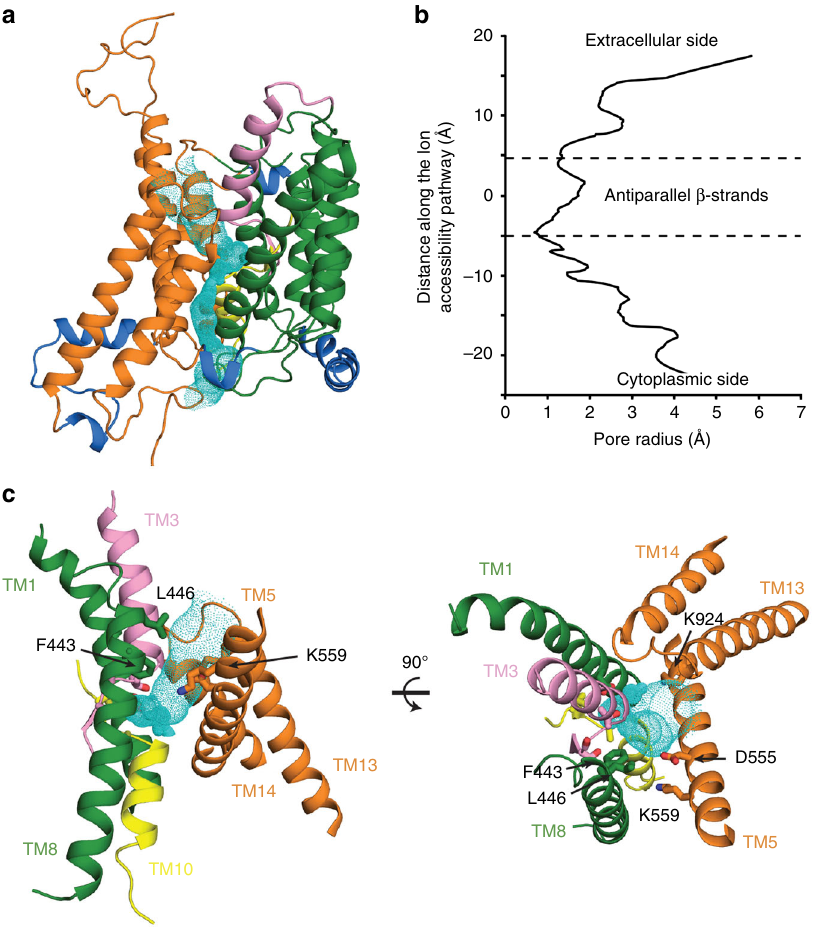
Fig. 2 Ion accessibility pathway of NBCe1. The ion accessibility pathway ( a , cyan mesh) and the pore radius value along the pathway ( b ). c Selected residues (Phe443, Leu446, Asp555, and Lys559) forming the pathway whose substitution signi fi cantly alters NBCe1 function 25 – 28 . Lys559 is known to bind to DIDS 27 , which inhibits NBCe1 function likely via blocking the ion accessibility pathway and/or the conformational changes during the transport